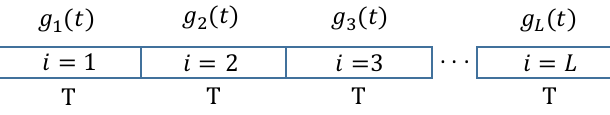
Figure 14. Coherent intervals in emission.